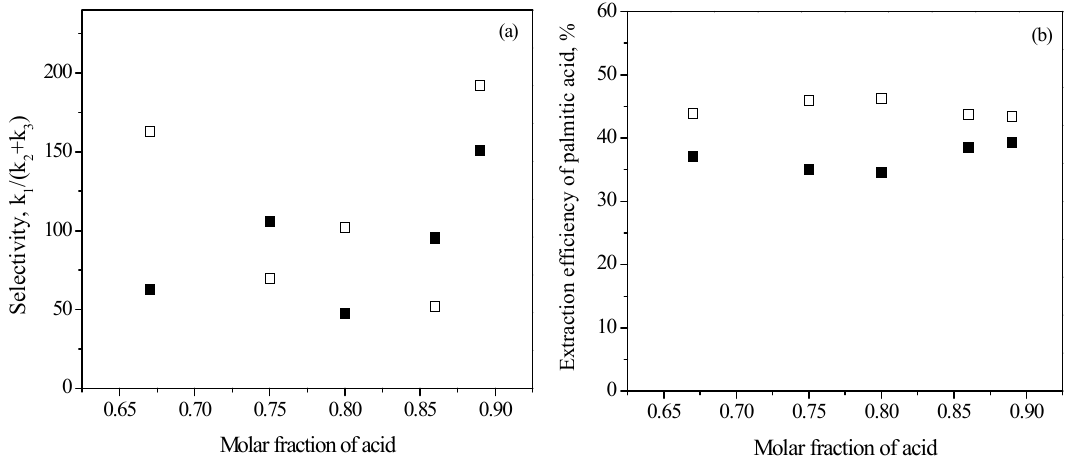
Figure 2. Selectivity of DESs ( a ) and extraction efficiency of palmitic acid ( b ); betaine monohydrate-propionic acid DESs ( □ ) and betaine monohydrate-acetic acid DESs ( ■ ), volume ratio of oil to solvent of 1:2, temperature of 40 °C, agitation at 250 rpm for 2 h.